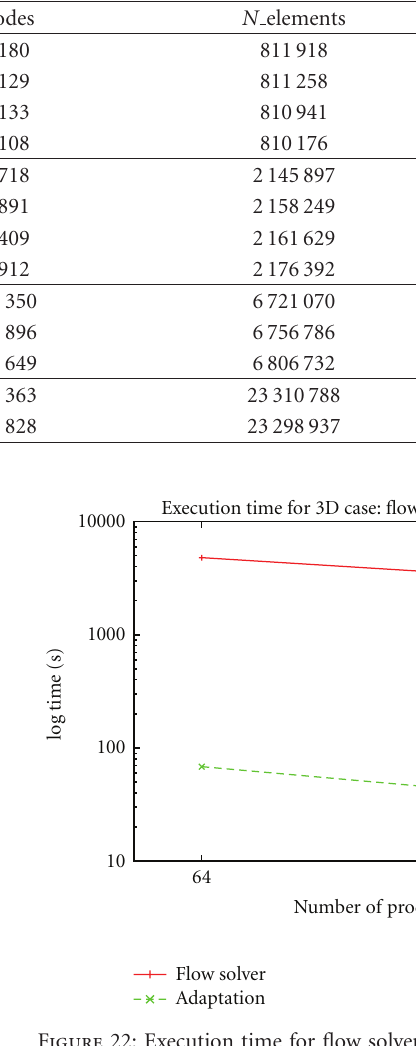
Table 3: Step-by-step grid sizes for di ff erent number of processors after 1, 2, and 3 adaptation steps, and after 1 adaptation step for 64 and 128 restarting from 32 final solution and grid. 3D wedge.